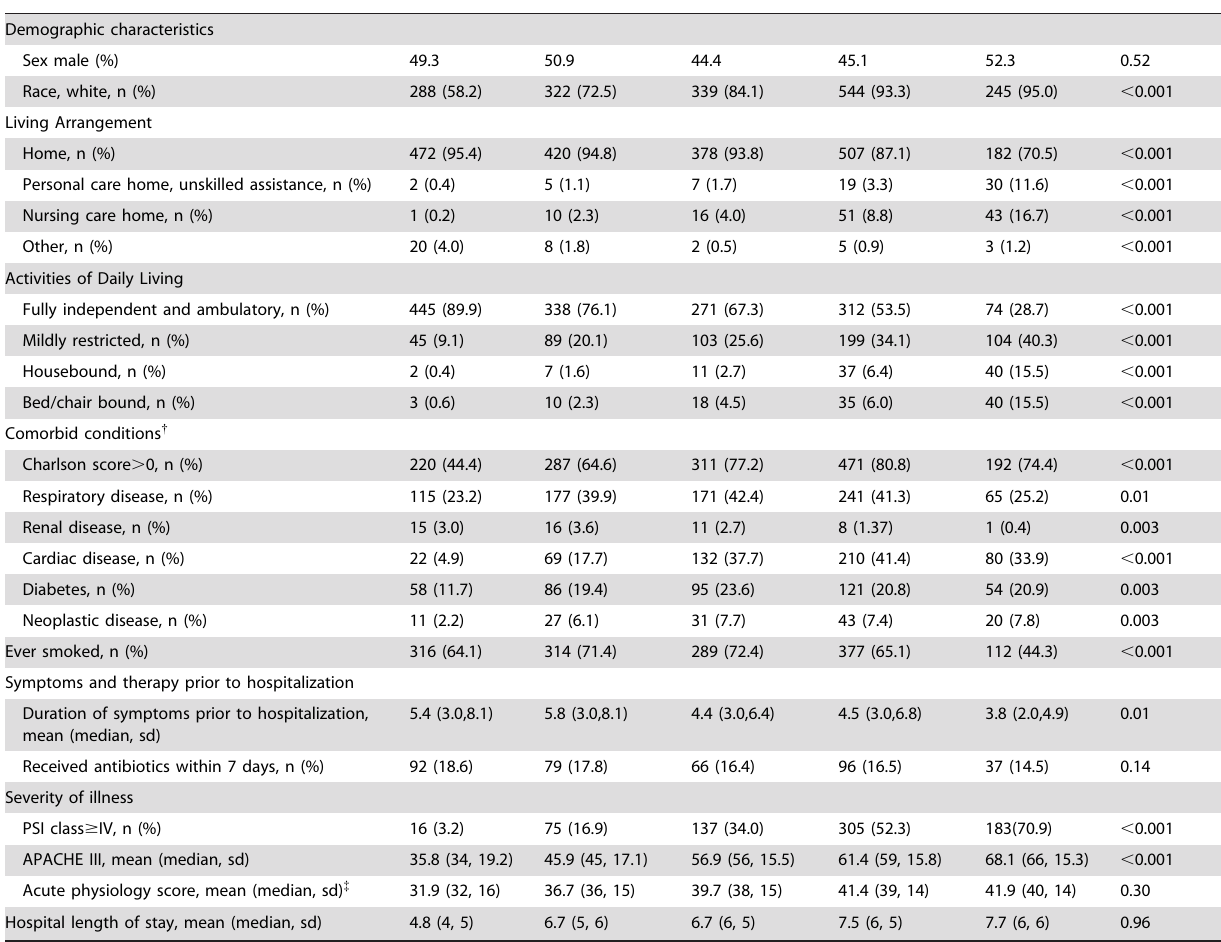
Table 1. Demographic and clinical characteristics stratified by